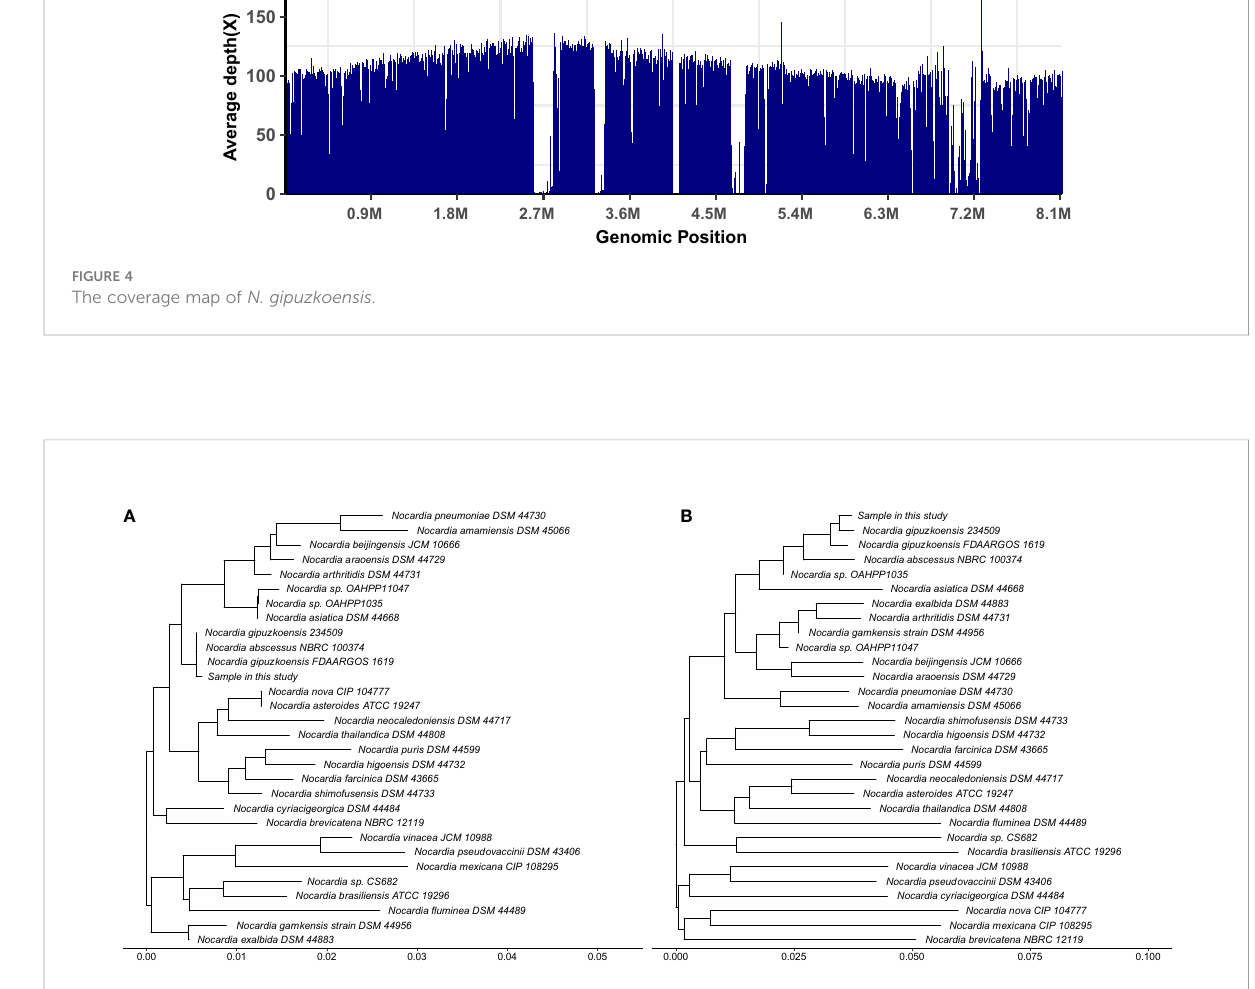
FIGURE 5 Phylogenetic trees based on the sequences of 16S rRNA gene (A) and housekeeping genes (B) show the phylogenetic position of the sample in this study within the evolutionary radiation of the genus Nocardia . The housekeeping genes contains hsp65 , secA1 , gyrB , and rpoB . The methods of determining phylogeny are following the steps: comparing multiple sequences by MAFFT, extracting conserved sequences by Gblocks, and then constructing the Neighbor-Joining by